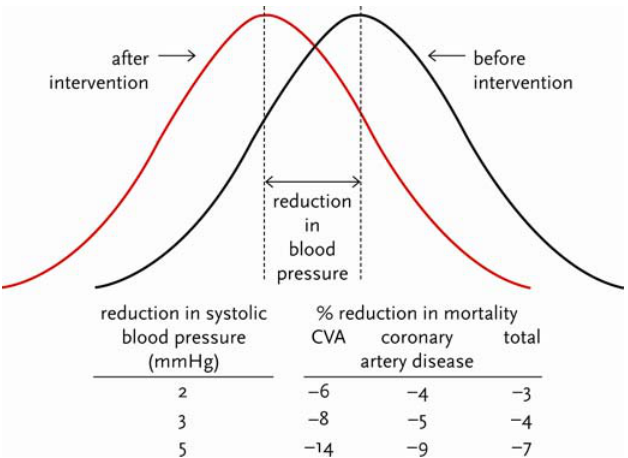
Figure 2. Systolic blood pressure distribution (the confidence interval were not reported, but were small given the sample size of n = 1,412, e.g., for the CVA patients